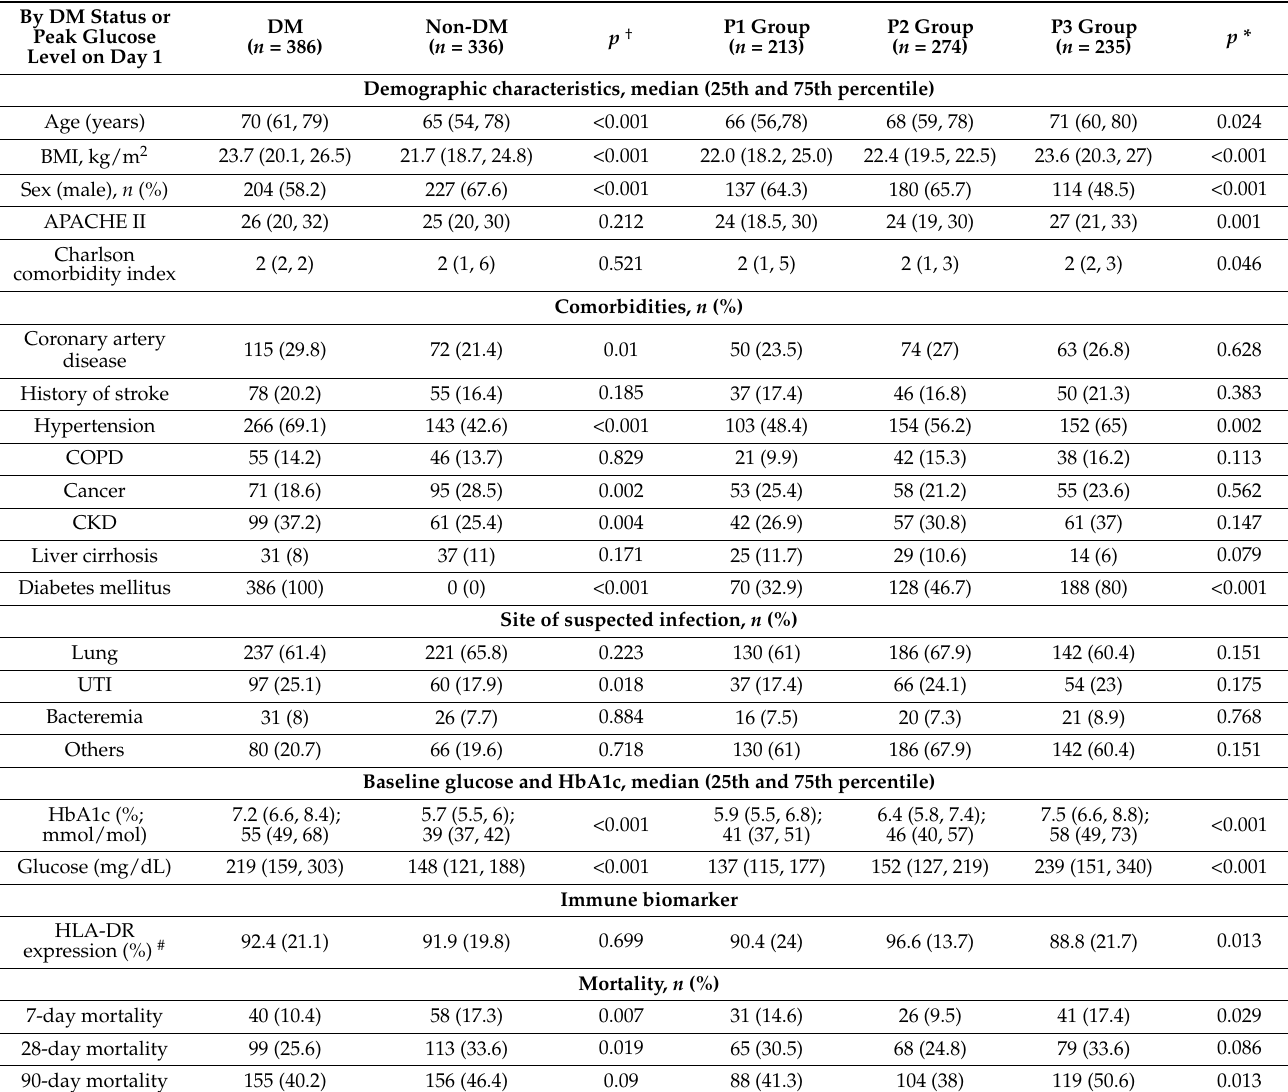
Table 1. Baseline characteristics and outcomes of septic patients in construction cohort.